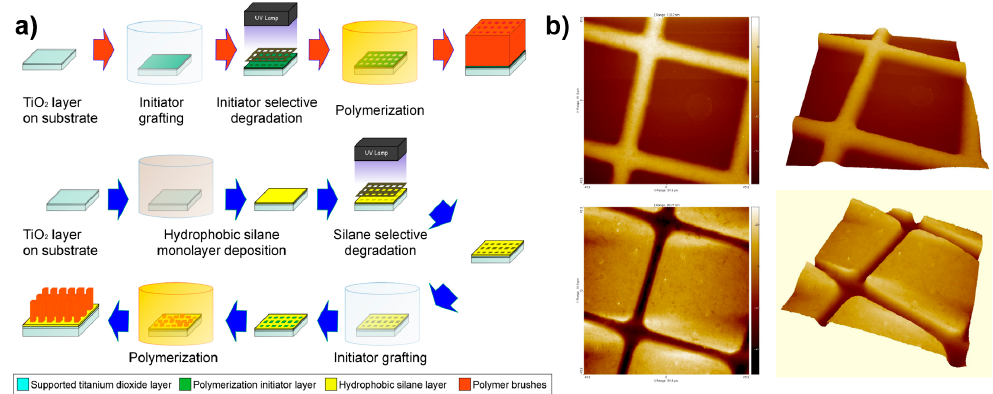
Figure 4. Positive and negative patterns of polymer brushes obtained by direct photocatalytic lithography: ( a ) schematic representation of the experimental procedures; ( b ) Atomic force microscopy (AFM) images of the corresponding positive and negative patterns of polymer brushes. Reproduced with permission from [42], Wiley, 2016.